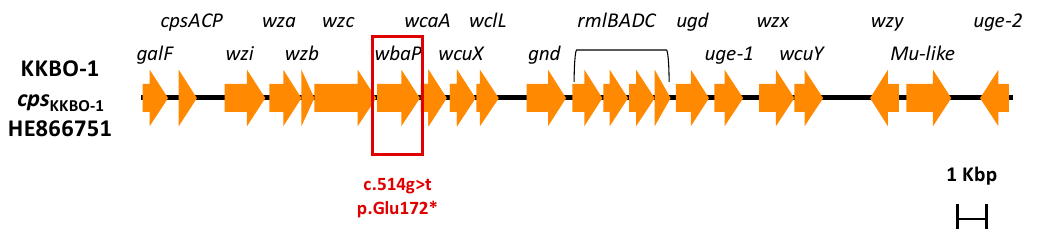
Figure 2. Spot test results confirming the restoration of susceptibility to ϕ BO1E infection observed in BO-FR-1(pACYC-wbaP). Strains are as follows: BO-FR-1 ( A ), KKBO-1 ( B ), BO-FR-1(pACYC- wbaP) ( C ) and ( D ). Ten μ L of cells in suspension of each strain were spotted on a LBA plate and partially layered with 5 μ L of ϕ BO1E (7 × 10 7 PFU/mL).